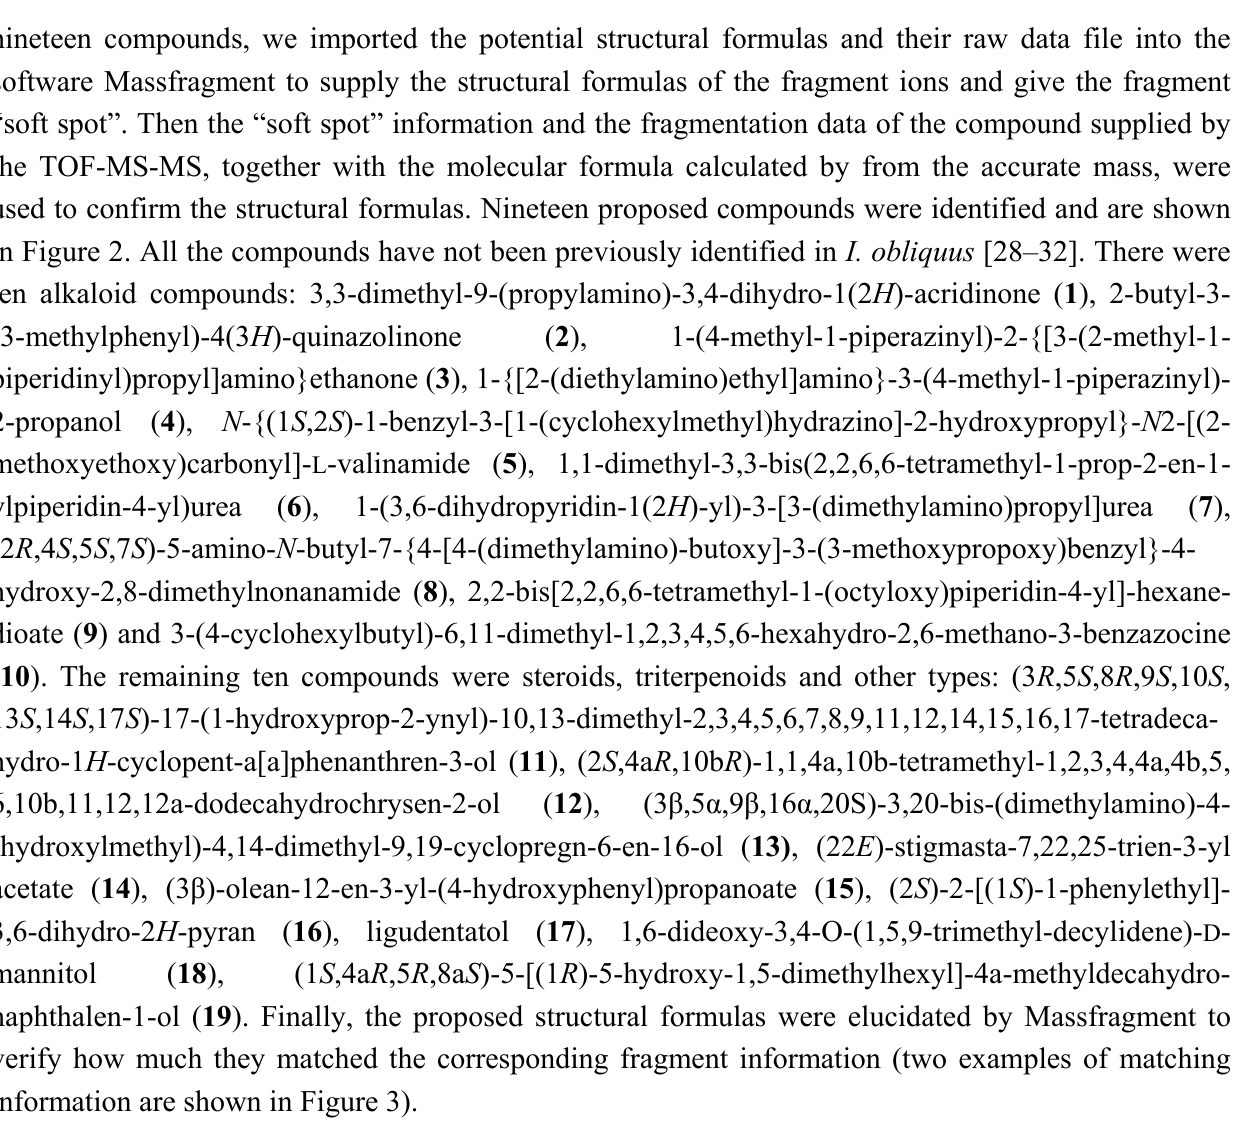
Table 1. Q-TOF-MS accurate mass elemental composition of the proposed compounds.